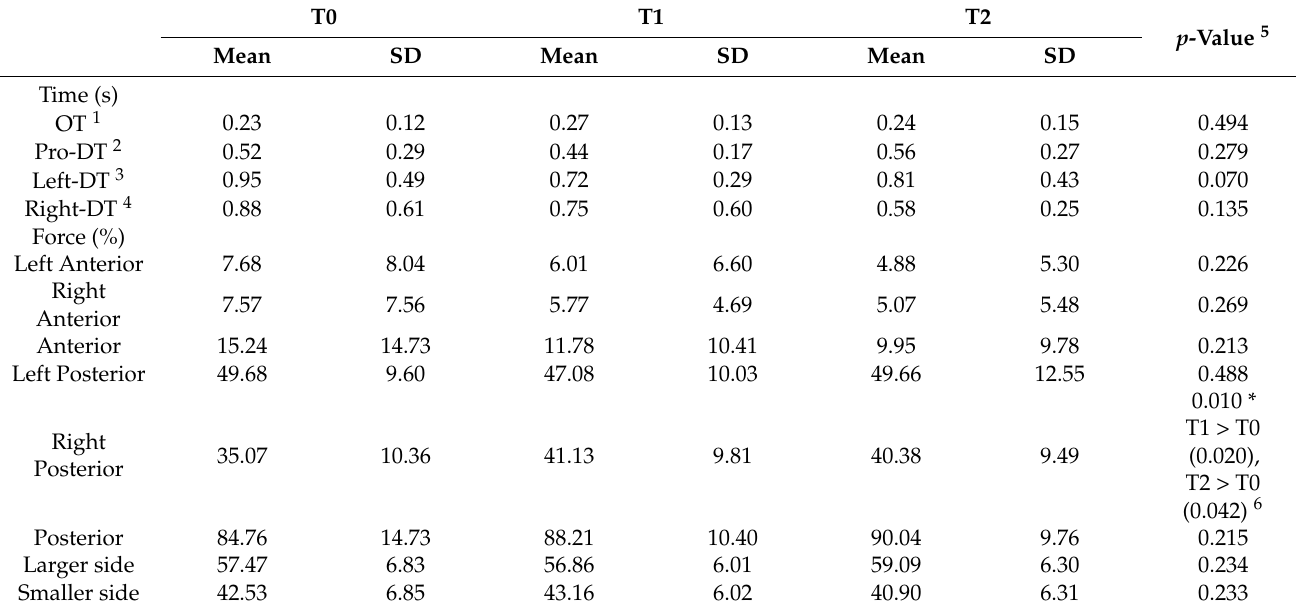
Table 2. Occlusal time and percentage of force distribution in subjects from T0 and